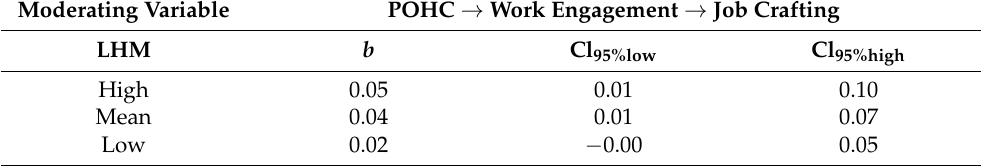
Table 5. Conditional indirect effect of POHC on job crafting through work engagement for levels of